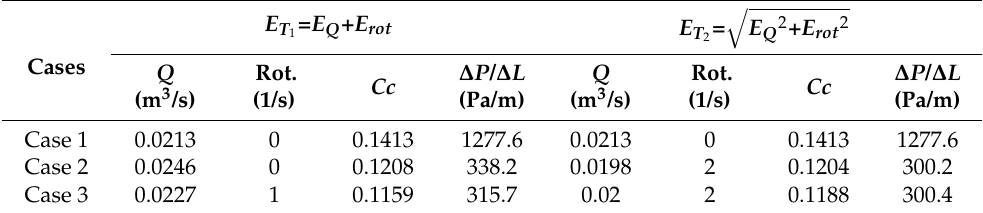
Table 7. Optimal flow rate and pipe rotation speeds when a 1 = 5000 ( Cc = 12%).